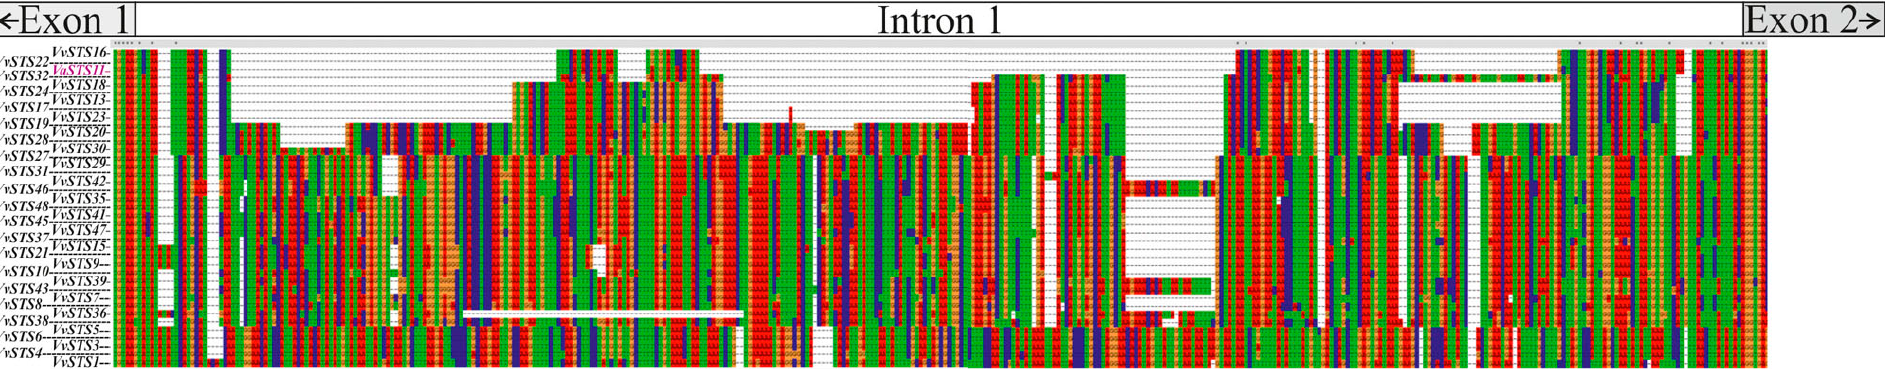
Figure 5. Schematic representation of the introns in the 38 functional Vitis vinifera VvSTSs genes (except VvSTS12 and VvSTS25 due to the lack of intron 1 sequence) and the Vitis amurensis VaSTS11 gene, a close homolog of the VvSTS16 and VvSTS22 genes